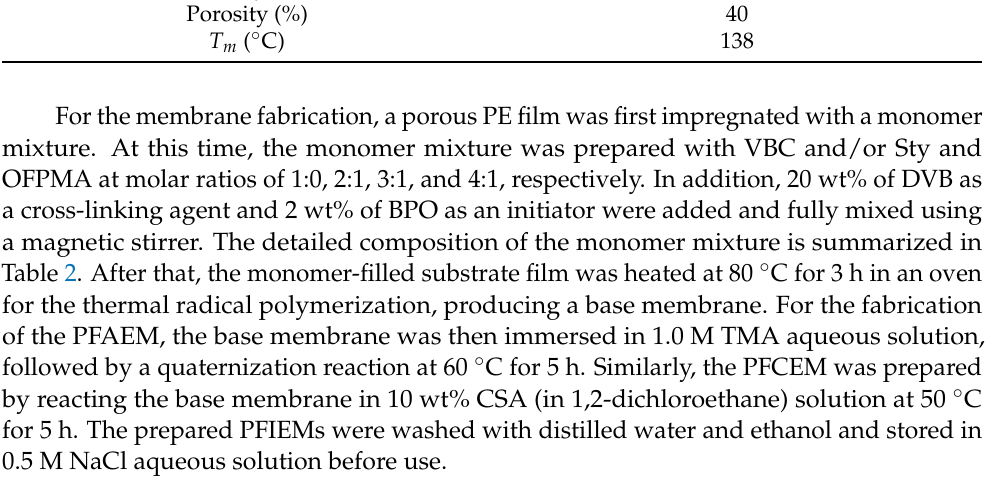
Table 2. Composition of monomers for fabricating PFAEMs and PFCEMs. Monomer Mole Membrane